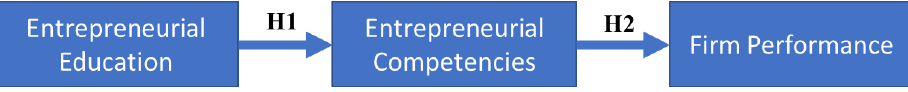
Figure 1. Conceptual